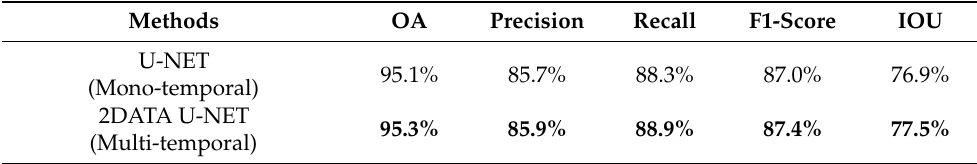
Table 3. Comparison of the accuracy of mono-temporal images and multi-temporal images. Methods